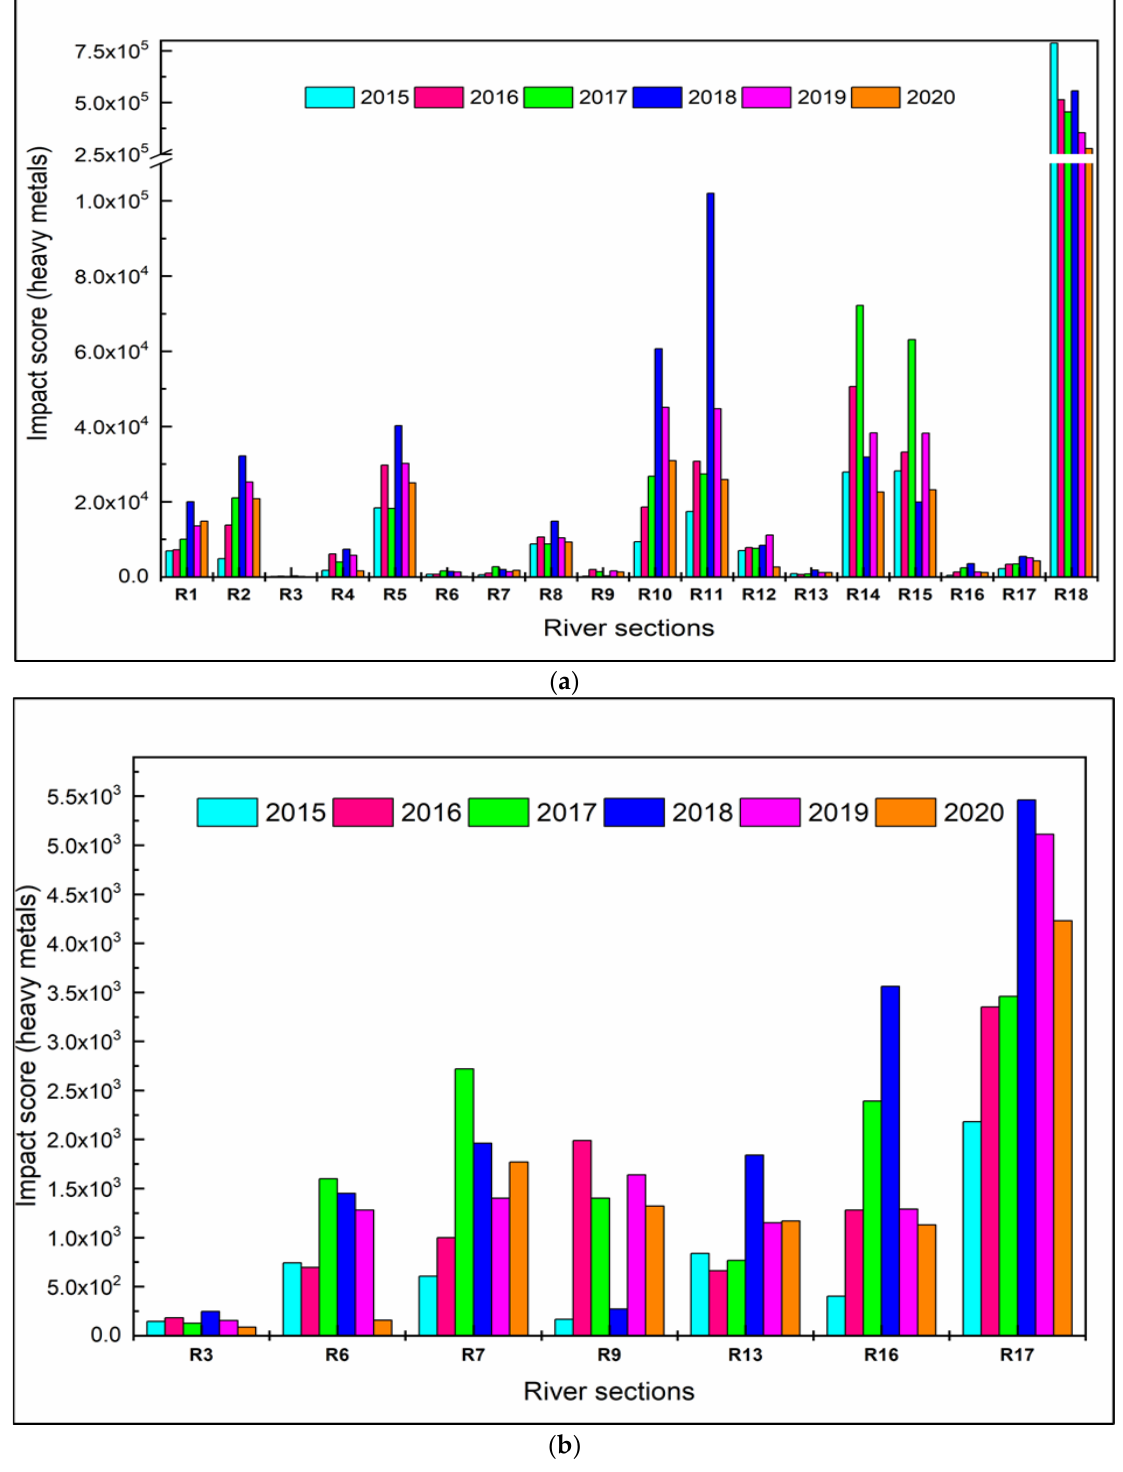
Figure 3. Non-carcinogenic impact score for heavy metals (2015–2020): ( a ) R1-R18 sections on the original scale; ( b ) a deeper view of selected sections (R3, R6, R7, R9, R13, R16, R17).